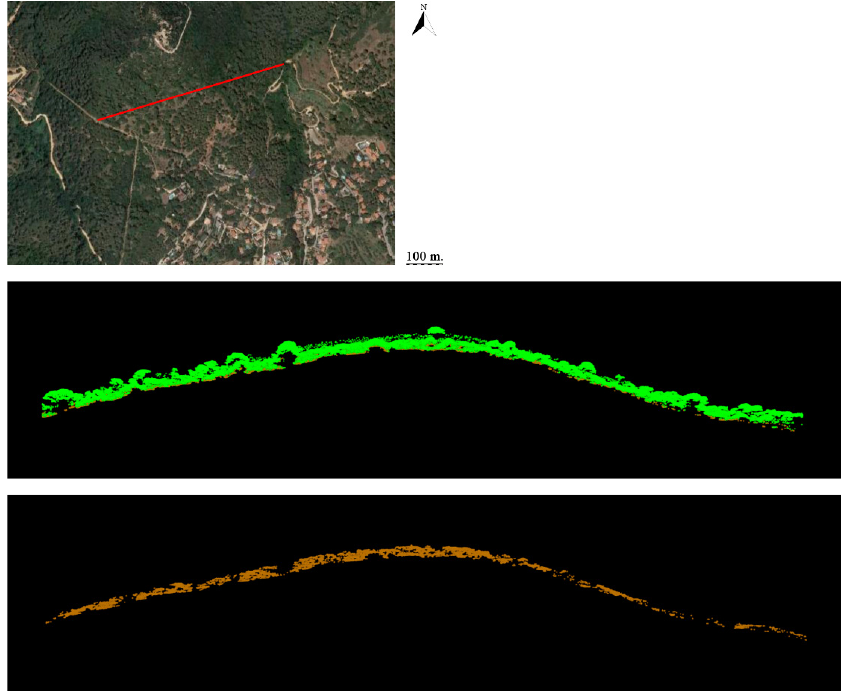
Figure 4. Profile view of the Burriac site ( centre ) and the same profile but only with the ground points ( class = 2) ( bottom ). The cut (red) is indicated in the satellite view of the site ( top ).